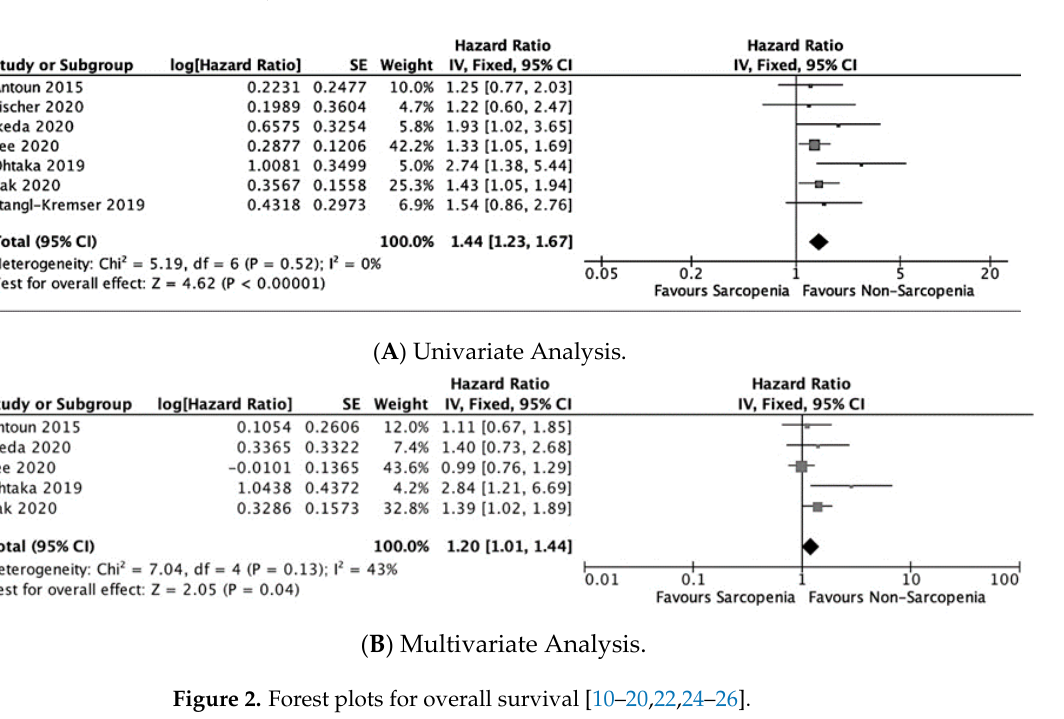
Figure 3. Forest plot for cancer-specific survival — Univariate Analysis [20,21]. Subgroup analysis of univariate data indicated a statistically significant association in patients with hormone-sensitive PCa (HR = 3.48, 95% CI: 1.43, 8.47, P = 0.05; n = 197). 3.3.3. Progression-Free Survival Four studies provided data on PFS [18,21,25,26]. The pooled analysis demonstrated an association between sarcopenia and shorter PFS, and this association existed in both univariate (HR = 1.56, 95% CI: 1.29, 1.88, P < 0.01; I 2 = 0%; k = 4; n = 818) and multivariate analyses (HR = 1.61, 95% CI: 1.26, 2.06, P < 0.01; k = 3; n = 588) (Figure 4). ( A ) Univariate Analysis.